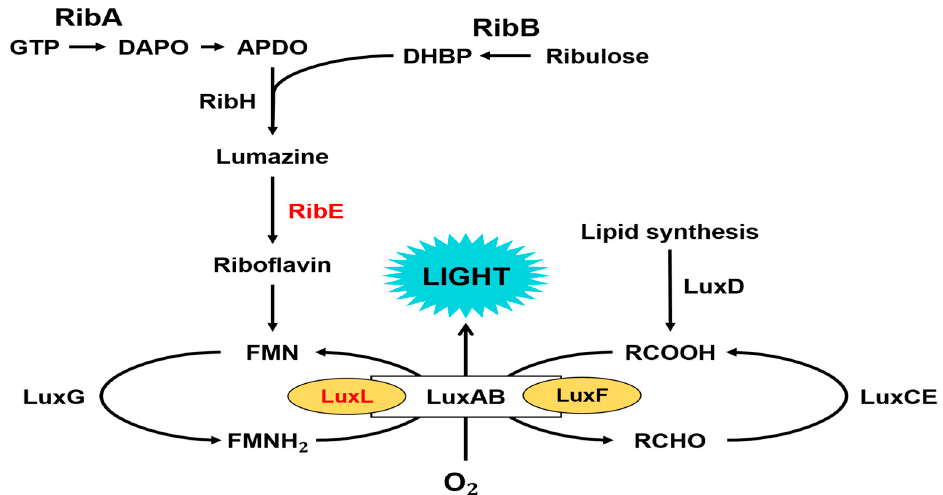
Figure 1. The complete catalytic reactions and proteins involved in light emission by Photobacterium phosphoreum . Proteins are as follows: lumazine protein (LuxL), α and β subunits of luciferase (LuxAB), fatty acid reductase complex (LuxCDE), non-fluorescent flavoprotein (LuxF), flavin reductase (LuxG), GTP cyclohydrolaseII (RibA), dihydroxy-butanone 4-phosphate synthase (RibB), lumazine synthase (RibH), and riboflavin synthase (RibE). Modified from reference [10].